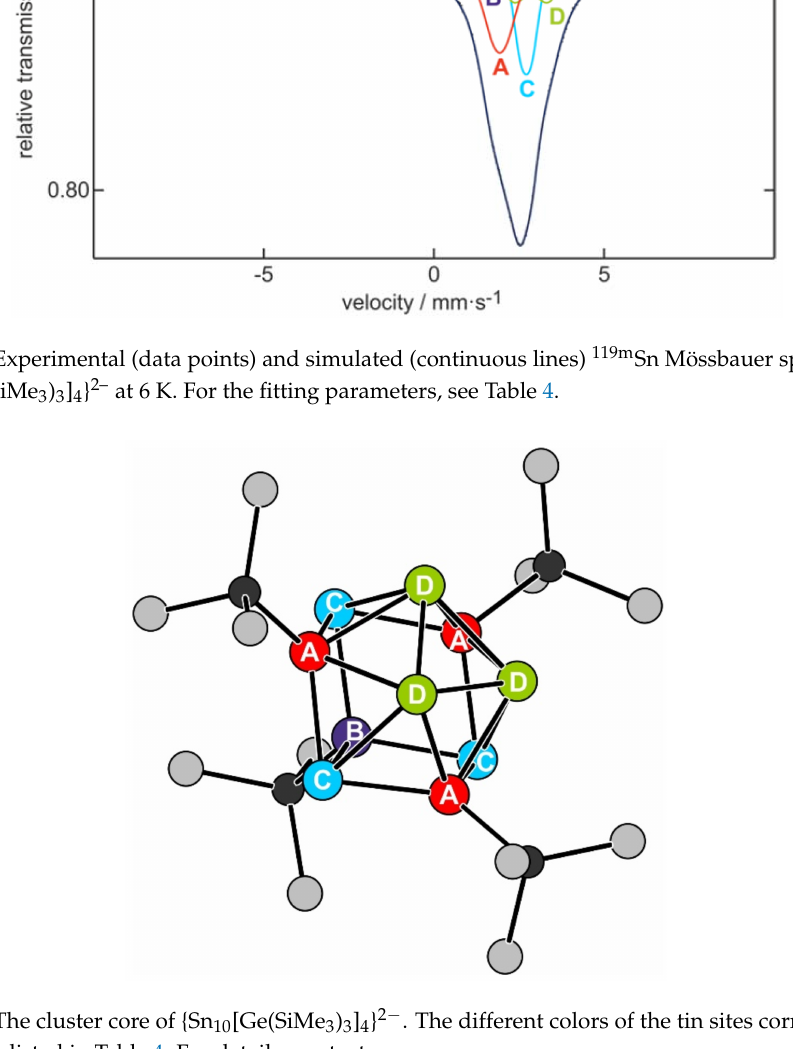
Figure 6. The cluster core of {Sn 10 [Ge(SiMe 3 ) 3 ] 4 } 2 − . The different colors of the tin sites correspond to the groups listed in Table 4. For details, see